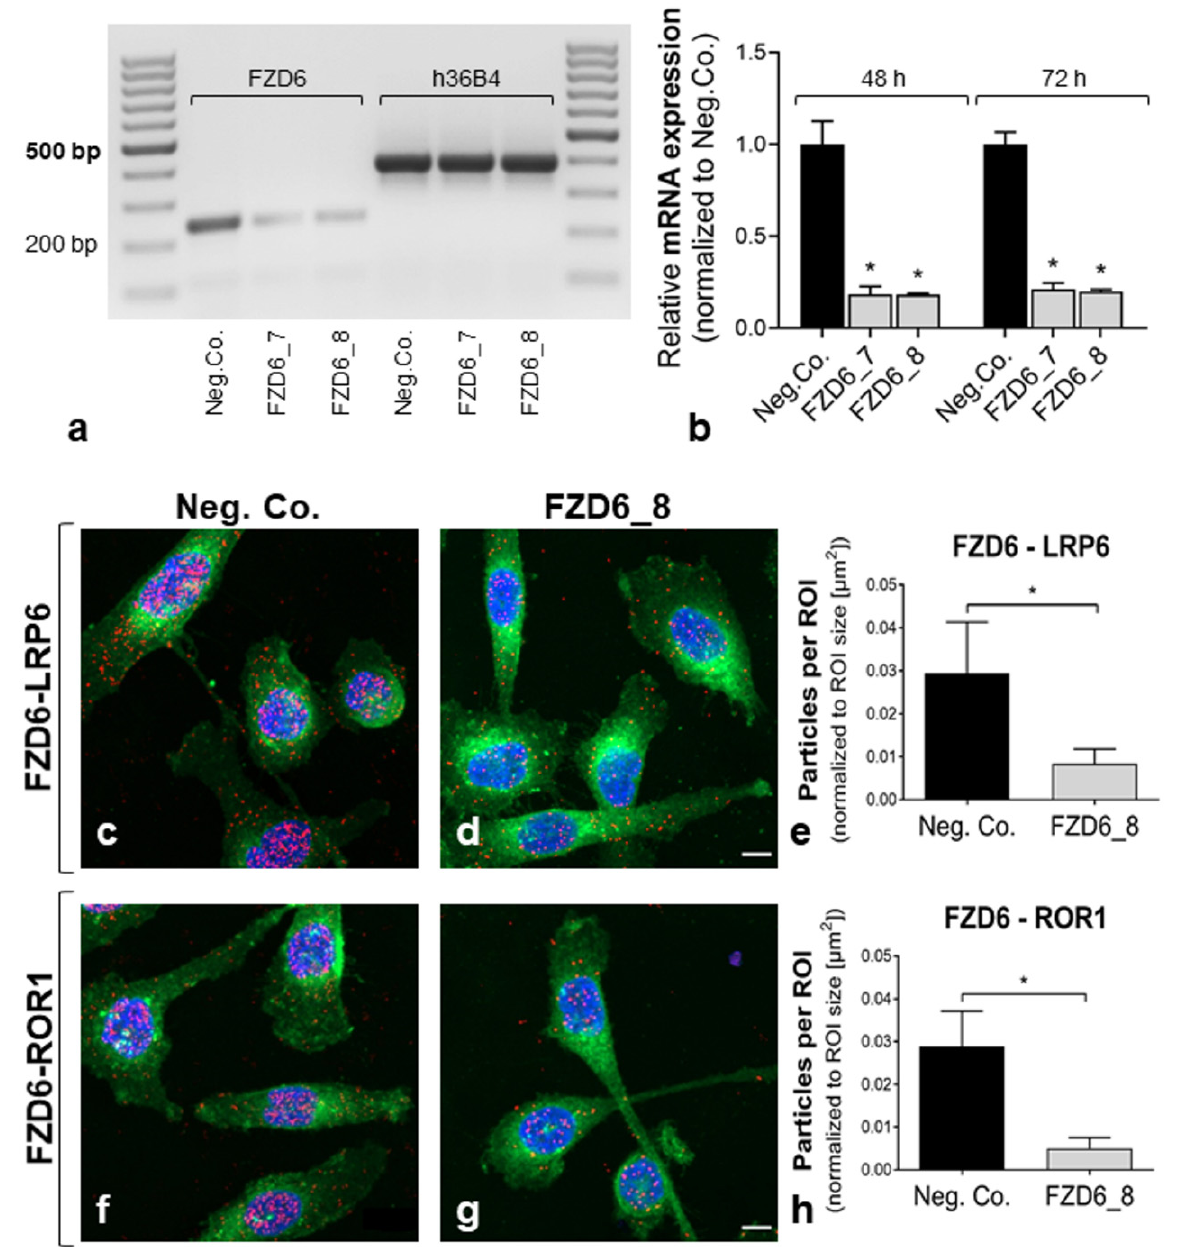
Figure 2. Verification of PLA specificity for the detection of FZD6 receptor complexes. Analysis of FZD6 receptor complexes after siRNA-mediated knockdown of FZD6. ( a , b ) FZD6 expression by qRT-PCR after treatment with specific siRNAs (FZD6_7, FZD6_8; vs. Neg. Co. siRNA). ( b ) The relative mRNA expression of FZD6 (normalized to h36B4 expression) was quantified 48 and 72 h after siRNA treatment. Quantification revealed a significant FZD6 knockdown (75%–80%) by siRNA targeting FZD6 vs. non-targeting siRNA (Neg. Co.). ( c – h ) Co-localization of FZD6 with co-receptors LRP6 and ROR1 by PLA after treatment with FZD6_8 siRNA for 48 h. FZD6–LRP6/ROR1 complexes (red); plasma membranes (green); nuclei (blue). Scale bar: 10 µ m. ( e , h ) The quantification of PLA signal density was performed by particle analyses at the single-cell level; particles were normalized to the area of cells. The number of FZD6–LRP6 and FZD6–ROR1 complexes was significantly decreased (70%–80%) after siRNA-mediated FZD6 knockdown (in accordance with mRNA expression after siRNA). * p ≤ 0.05, Mann–Whitney Test; mean + SD; n = 3 independent experiments.